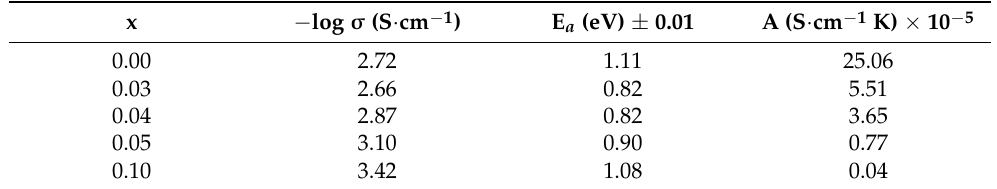
Table 3. Oxygen ion conductivity values ( σ ) at 640 ◦ C, activation energies (E a ) and pre-exponential factor (A) for Gd 2 − x Mg x Zr 2 O 7 − x/2 .